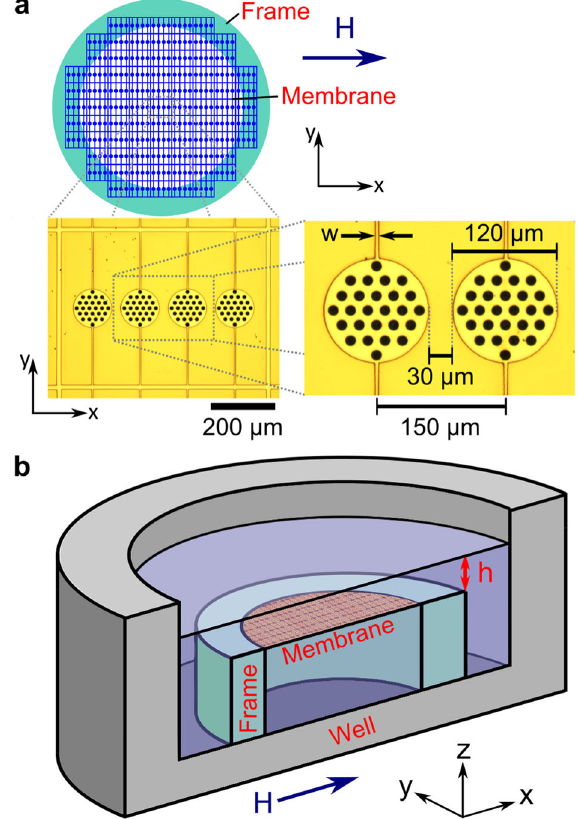
Fig. 1 Sample geometry. a Schematic diagram of the whole membrane covering the frame, showing the approximate scaling of the cells to the inner diameter of the frame. The details show microscopy images of a single paddle cell within the membrane, highlighting critical dimensions of the active elements ( w = 3 – 12 µ m). Magnetic cylinders appear as dark circles. b Schematic cross-section of experimental